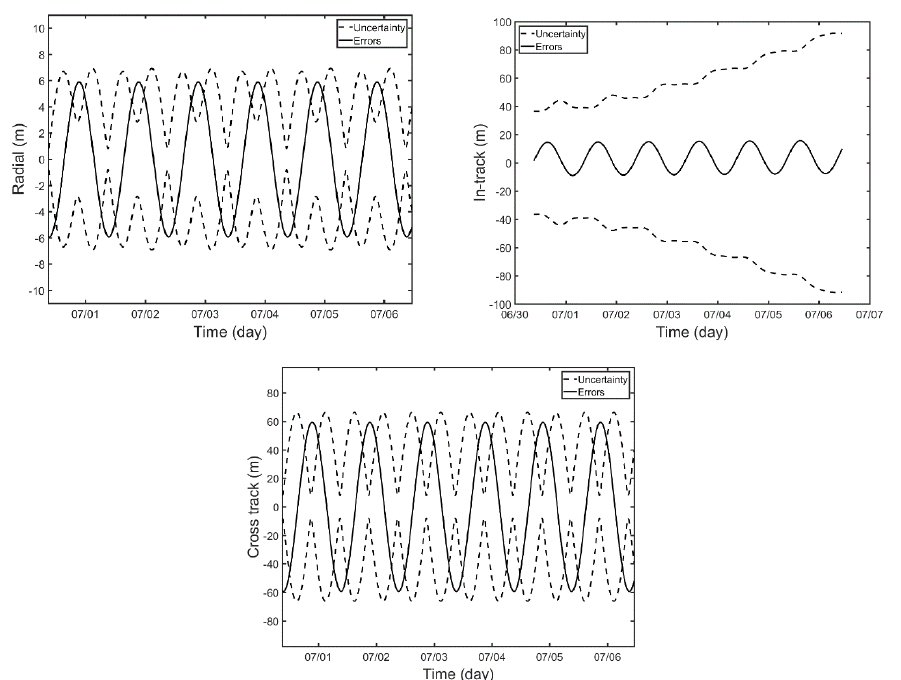
Figure 9. Estimated orbit uncertainty and orbital errors for Scenario 1 in radial ( upper left ), in-track ( upper right ), and cross-track ( lower ) directions.